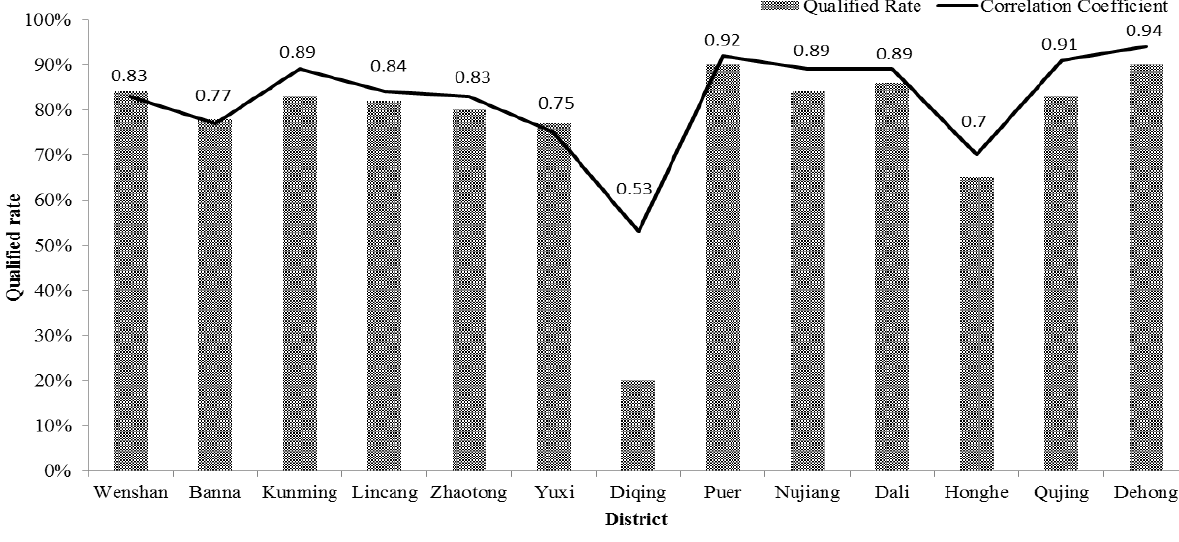
Figure 9. Prediction results of the thirteen districts in Y unnan